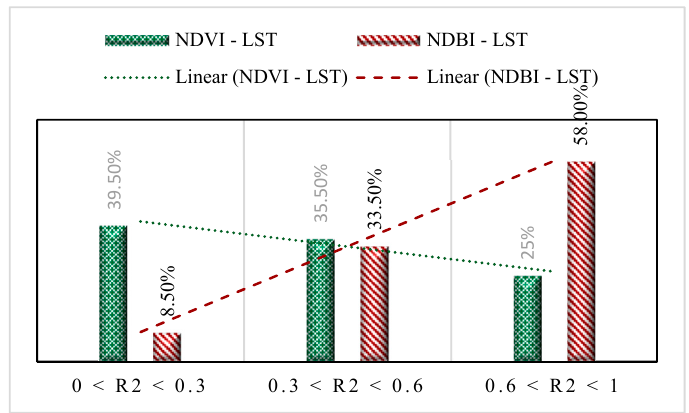
Figure 7. Quantitative classification of the previous works studying NDVI-LST and NDBI-LST relationships. Table 7. The correlation of NDVI-LST and NDBI-LST relationships of previous case studies in various climate classes.